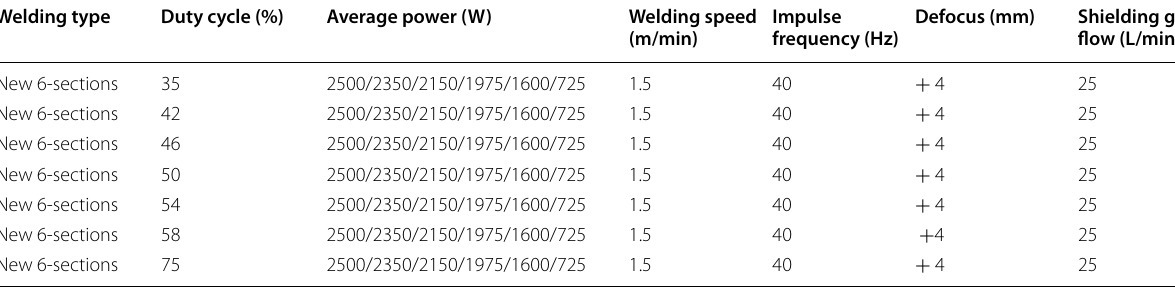
Table 3 Process parameters under different duty cycles Welding